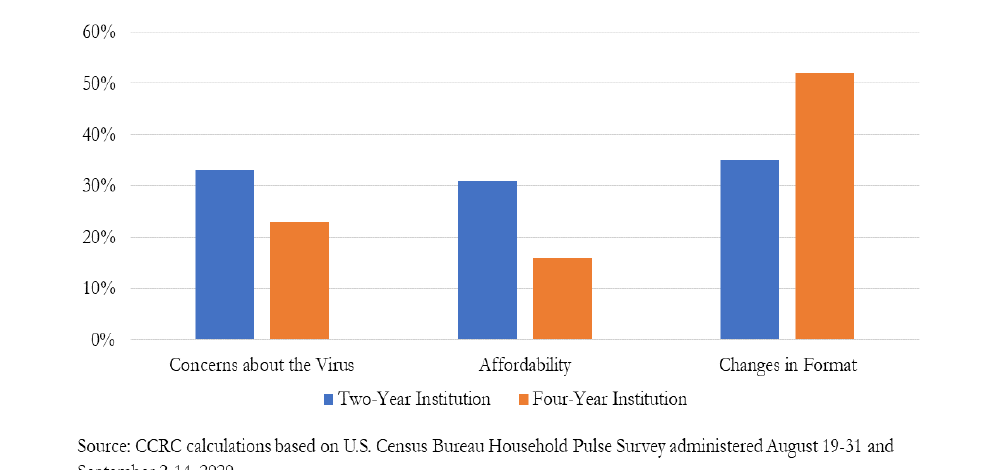
Figure 4: Reasons for Canceling or Changing Plans for College, Fall